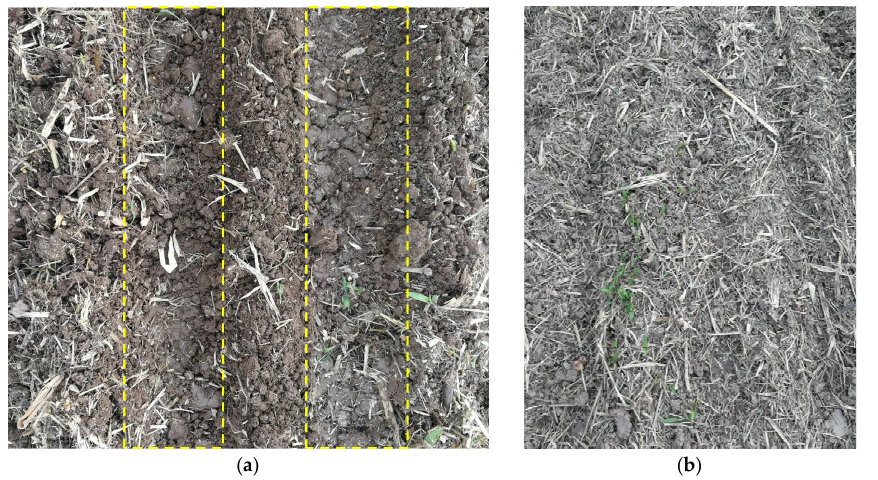
Figure 12. Straw cleaning effect in sowing belt after the operation. ( a ) Sowing belt cleaning effect with SSARD; ( b ) sowing belt cleaning effect without SSARD. Table 6. Field test results of straw cleaning effect of sowing